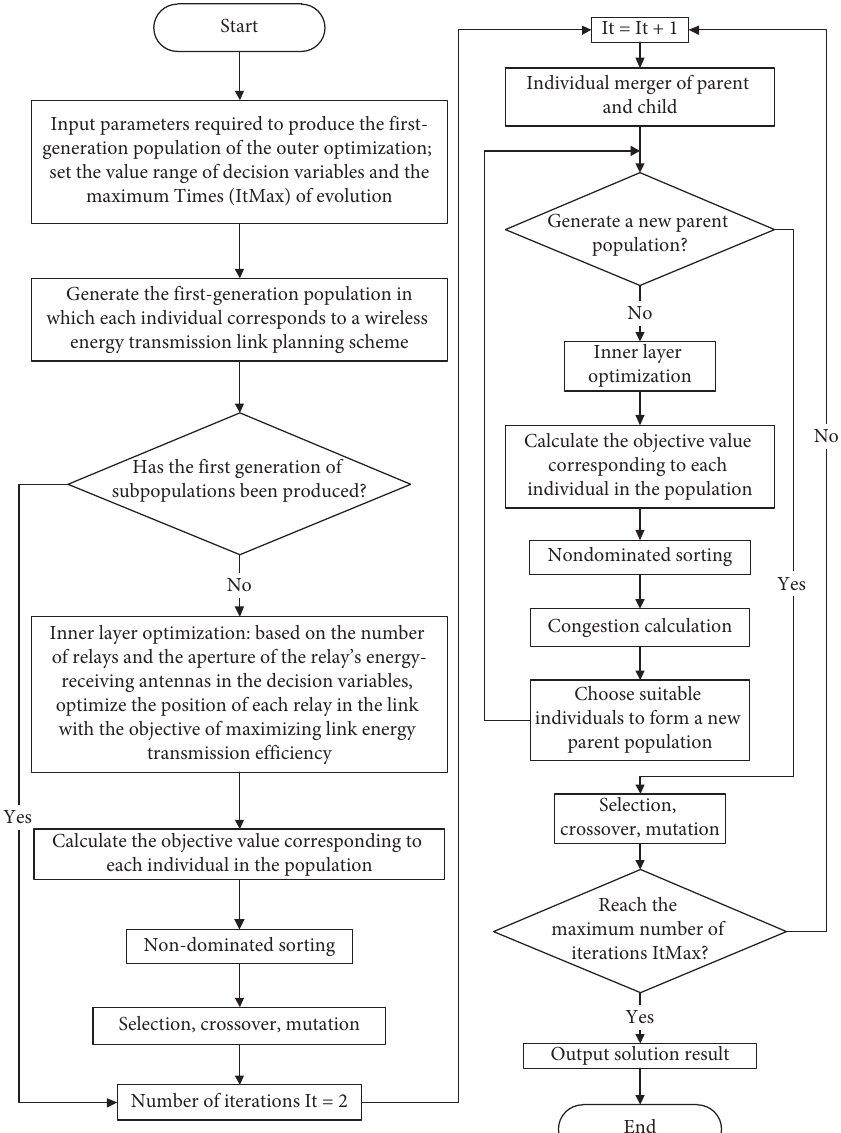
Figure 3: The solution process of the wireless energy transmission link planning model considering energy relay